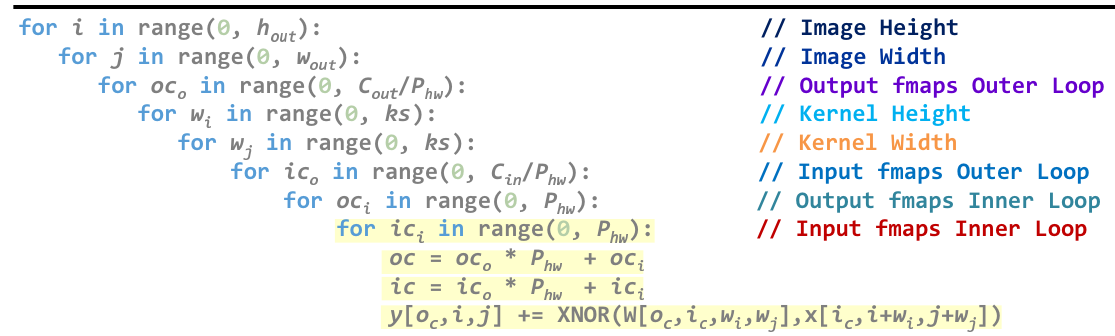
Figure 5. BNN layers’ loop for the second parallelism scheme; the loops highlighted in light yellow are computed in one clock